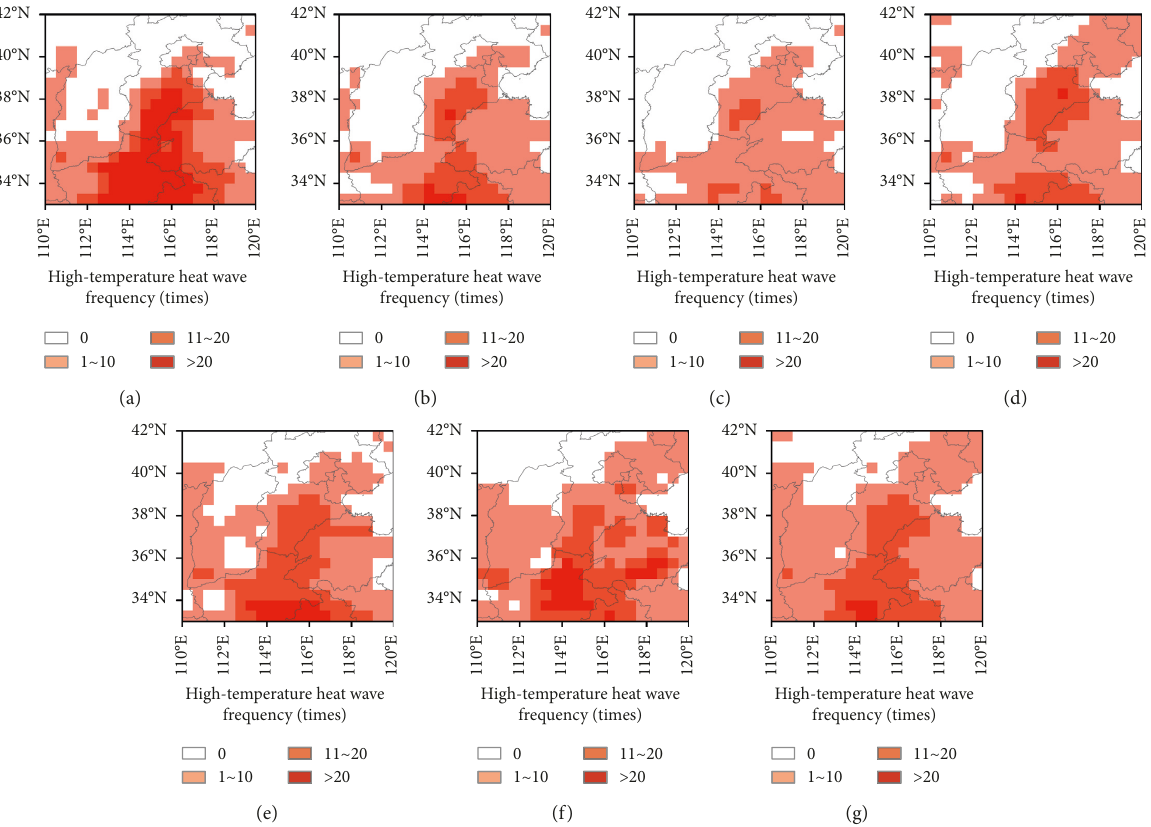
Figure 5: Spatial distribution of the annual average frequency of heatwaves on the North China Plain. (a) 1961–1970, (b)